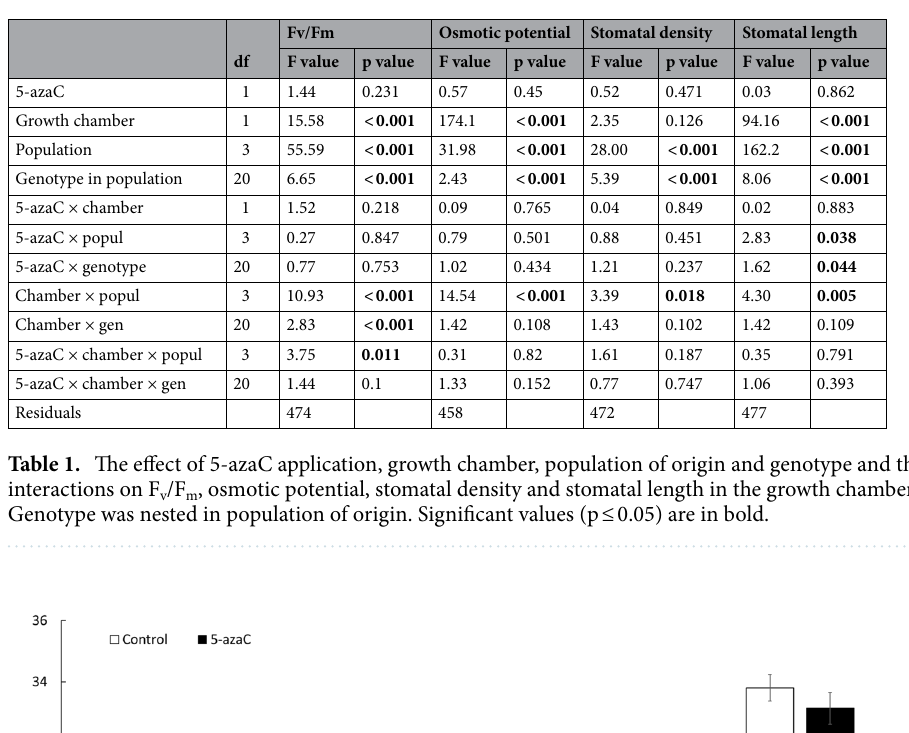
(Table 1, Fig. 2). Plants from the warm-wet locality and treated with 5-azaC had longer stomata than controls (on average by 1.25 μm, i.e. 4%), but no significant effect of 5-azaC was detected in the plants from the other localities (Fig. 2). The effect of 5-azaC application on stomatal length also differed among the genotypes (Table 1). When tested separately by genotype, the control and 5-azaC treated individuals of four genotypes (out of 24 genotypes in the experiment) differed significantly in stomatal length with the highest difference of 4.18 μm between the treat- ments. Out of these, two showed significant increase in the stomatal length after 5-azaC (one genotype from cold-dry and one from warm-wet locality) and the other two significant decrease (one from cold-wet and one from warm-dry, Fig. 3). For maximum photosystem II efficiency (F v /F m ), a significant triple interaction of 5-azaC, plant origin and growth chamber was detected (Table 1). Plants originating from the cold-dry locality treated with 5-azaC and grown in the cold-dry growth chamber had significantly higher F v /F m (by ± 0.012 on average) than the corre- sponding control plants. No significant difference was detected in any other combination (Fig. 4).